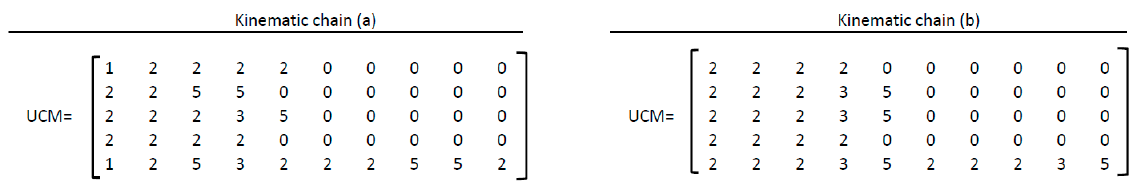
Figure 11. Two 8-link kinematic chains with simple and multiple joints. ( a ) kinematic chain: a. ( b ) kinematic chain: b. The link assortment array (LAA) and joint assortment array (JAA) for the KCs shown in Figure 11a,b are illustrated in Table 5. Table 5. Link Assortment Array and Joint Assortment Array for kinematic chains in Figure 11a,b. Kinematic Chain (a)